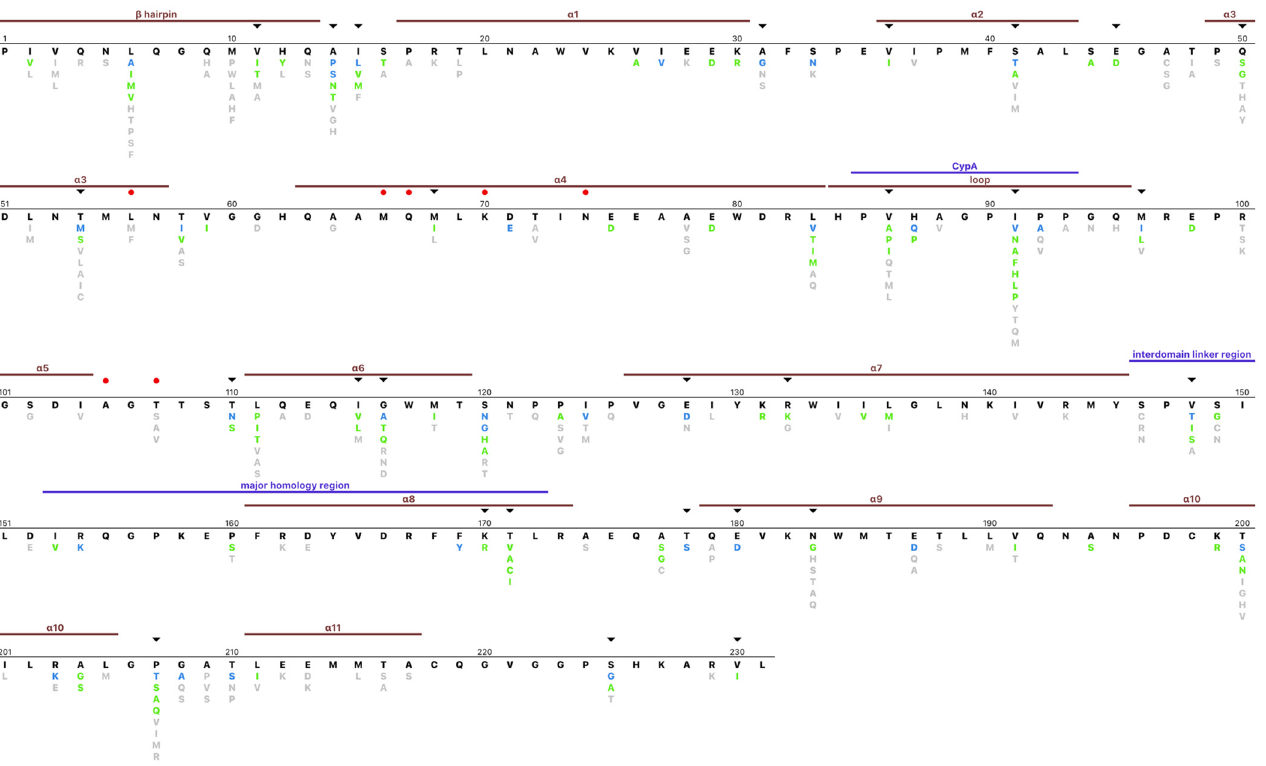
Figure 3. HIV-1 capsid Group M amino acid profile. The consensus sequence is indicated in black.